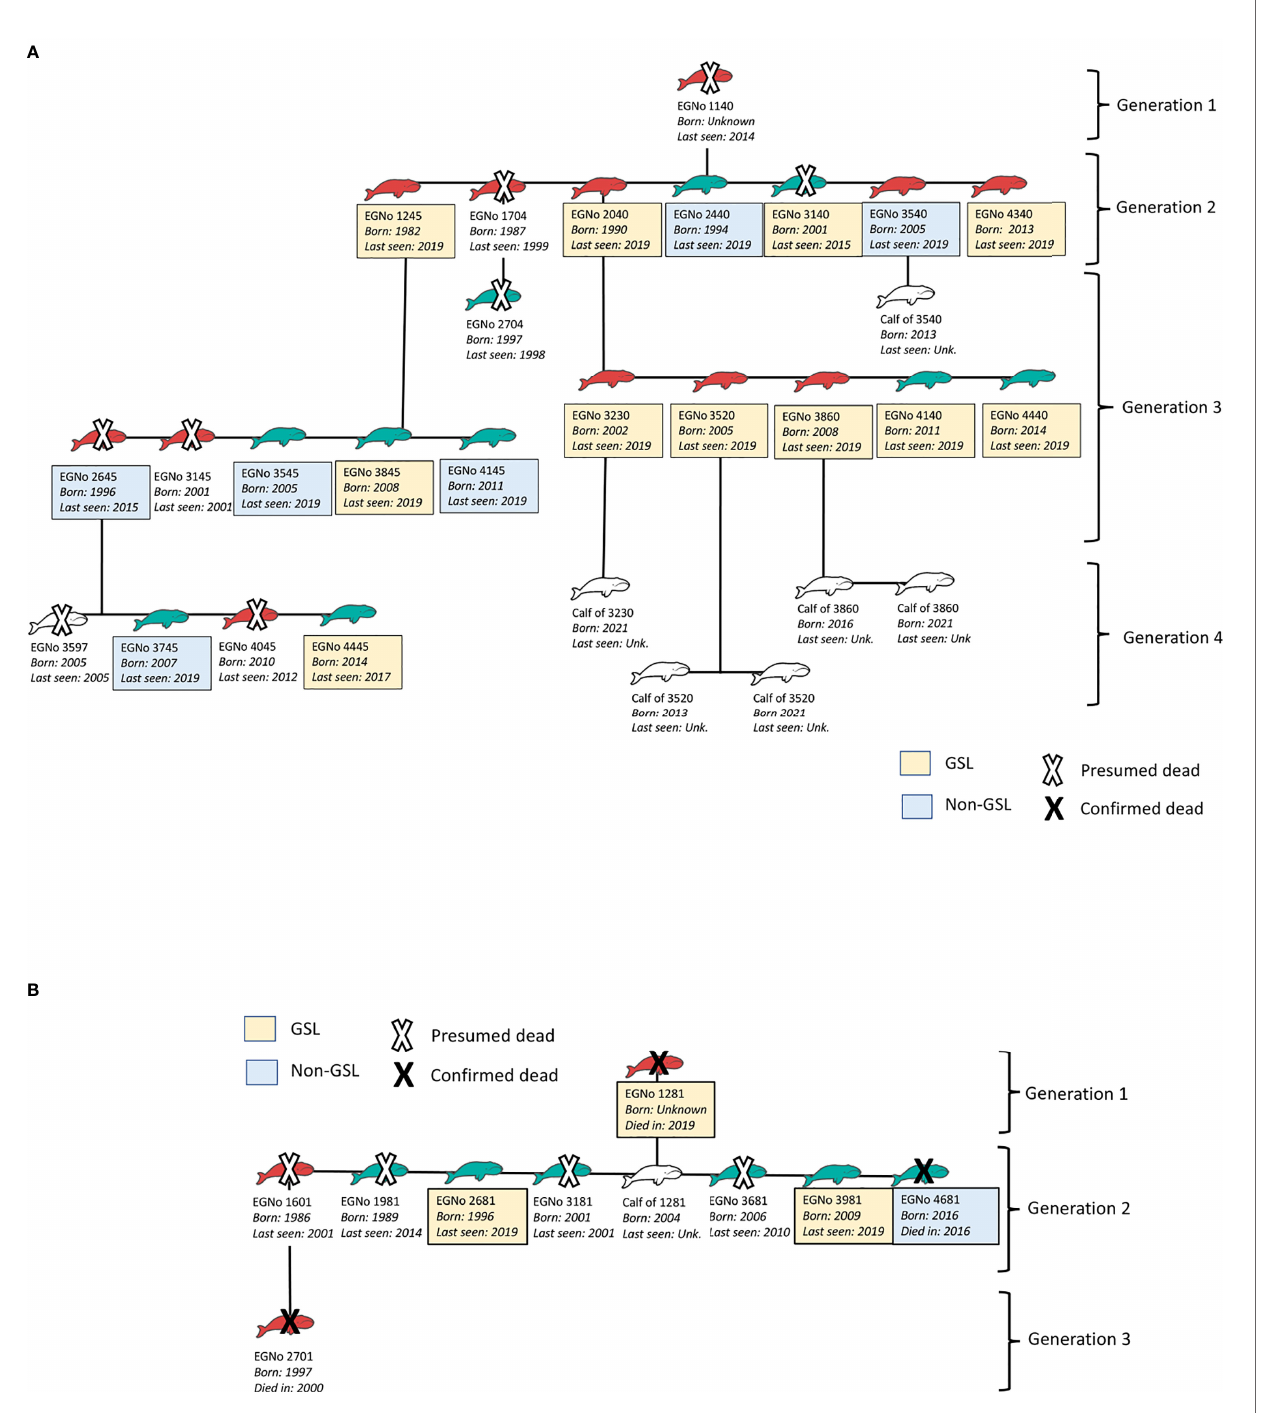
FIGURE 3 | Schematics showing the direct descendants of two right whale matriarchs and their progeny. (A) shows the matriline produced by matriarch #1140, and (B) shows the matriline produced by matriarch #1281. Blue icons indicate males, red icons indicate females, and white icons are individuals of unknown sex. Text below each icon lists the individual identi fi cation number, birth year, and year last sighted or year of death. Complete sightings data in this study were only assessed through 2019, so individuals last seen in 2019 may have been seen more recently, but complete calving data is shown through the 2021 birthing season. Text boxes with a yellow background indicate individuals that have been seen in the Gulf of St. Lawrence since 2015, and text boxes with a blue background indicate individuals that have been sighted since 2015, but not in the Gulf of St. Lawrence. Text boxes without a colored background indicate individuals that have not been sighted in 2015 or after. Whale icons with a white X are presumed to have died, and those with a black X have had their death visually con fi